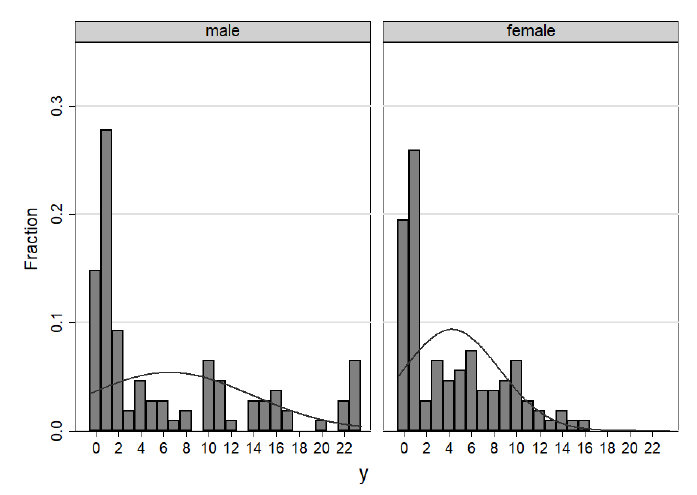
Figure 6. Distribution of average intended offer y by sex.